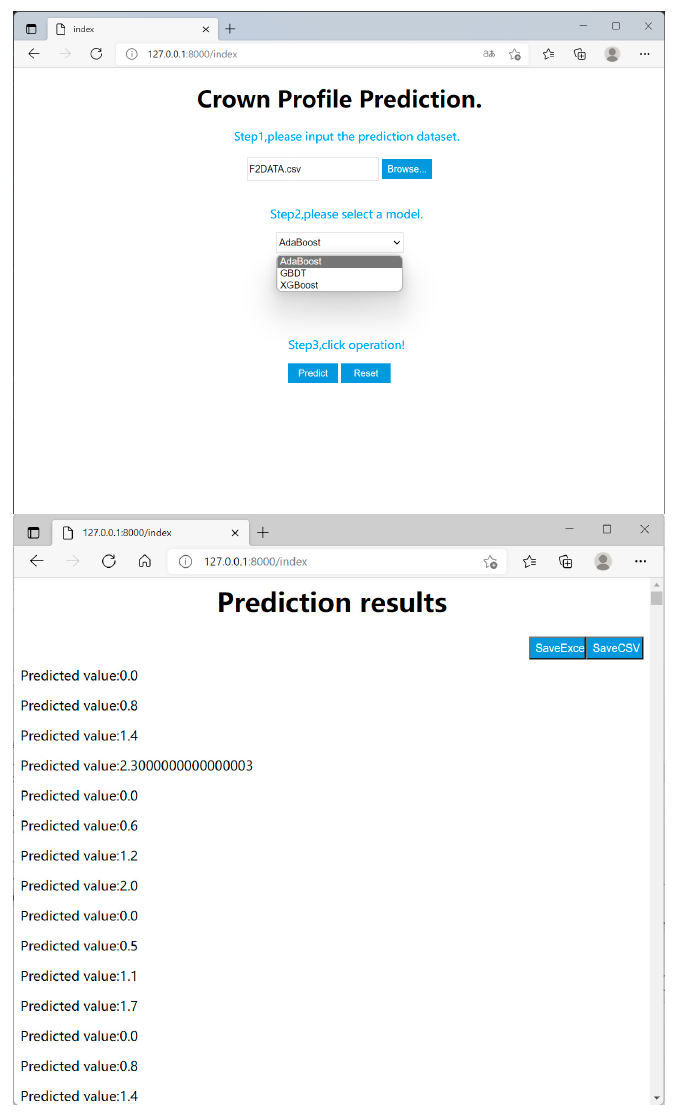
Figure 7. Model information and calculation interface.